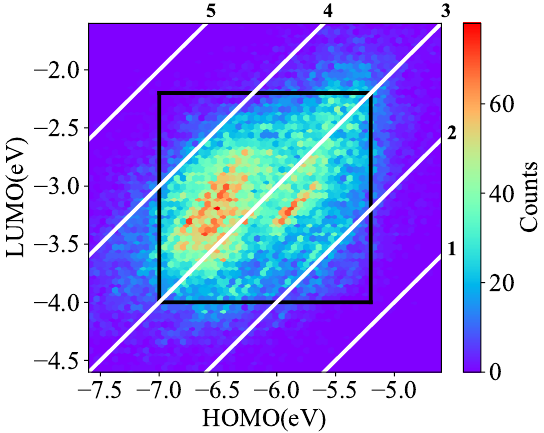
Figure 3. The distribution of NFAs for training the deep learning models (the white diagonals are the constant bandgap of the HOMO and